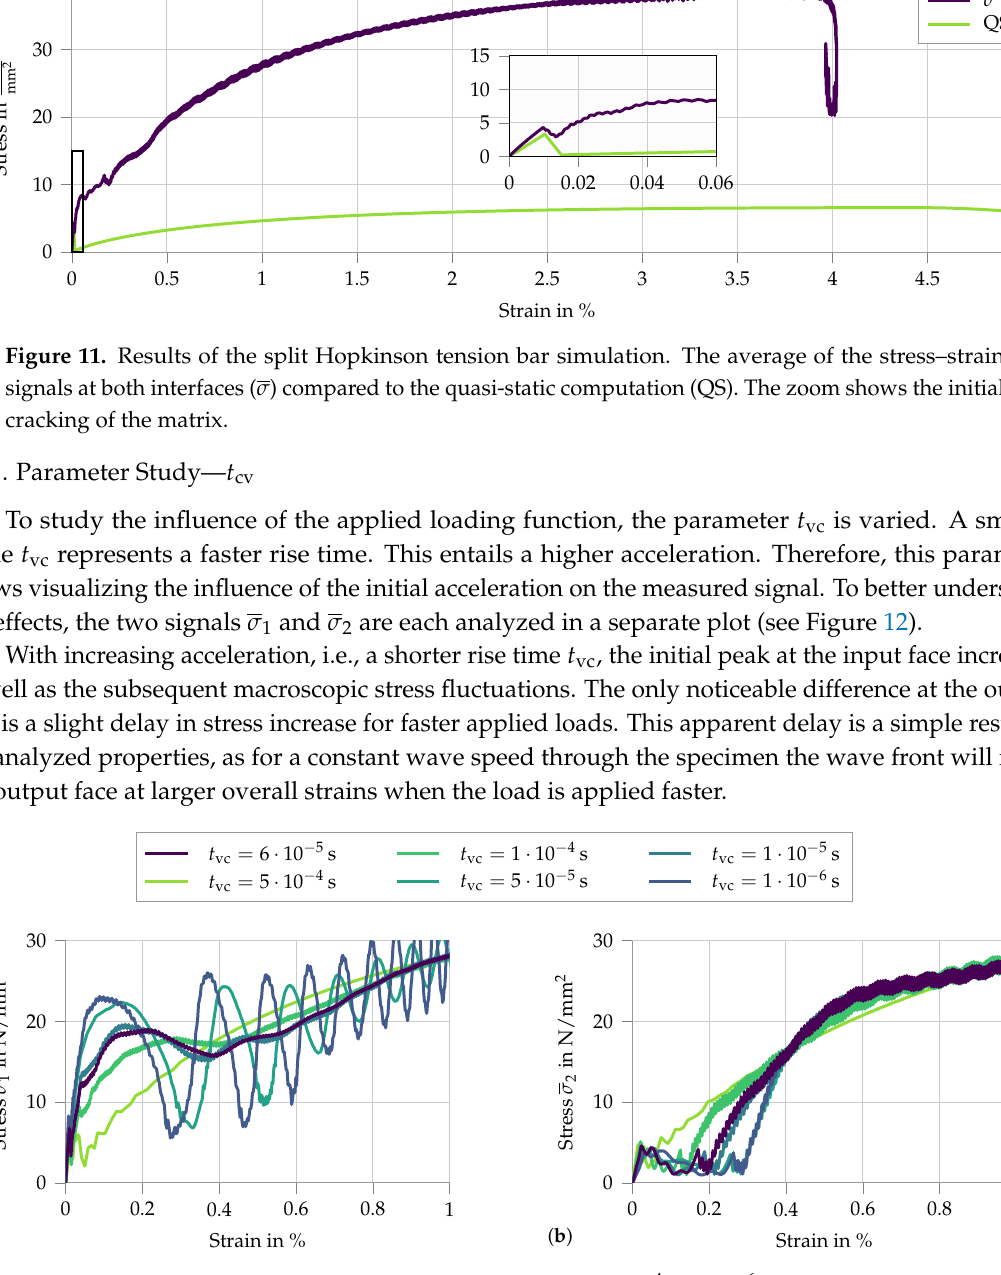
Figure 12. Analysis of the variation in rise time t cv from 5 × 10 − 4 s to 10 − 6 s, with v c = 3540mm/s: ( a ) the signal σ 1 at the input face; and ( b ) the respective signal σ 2 at the output